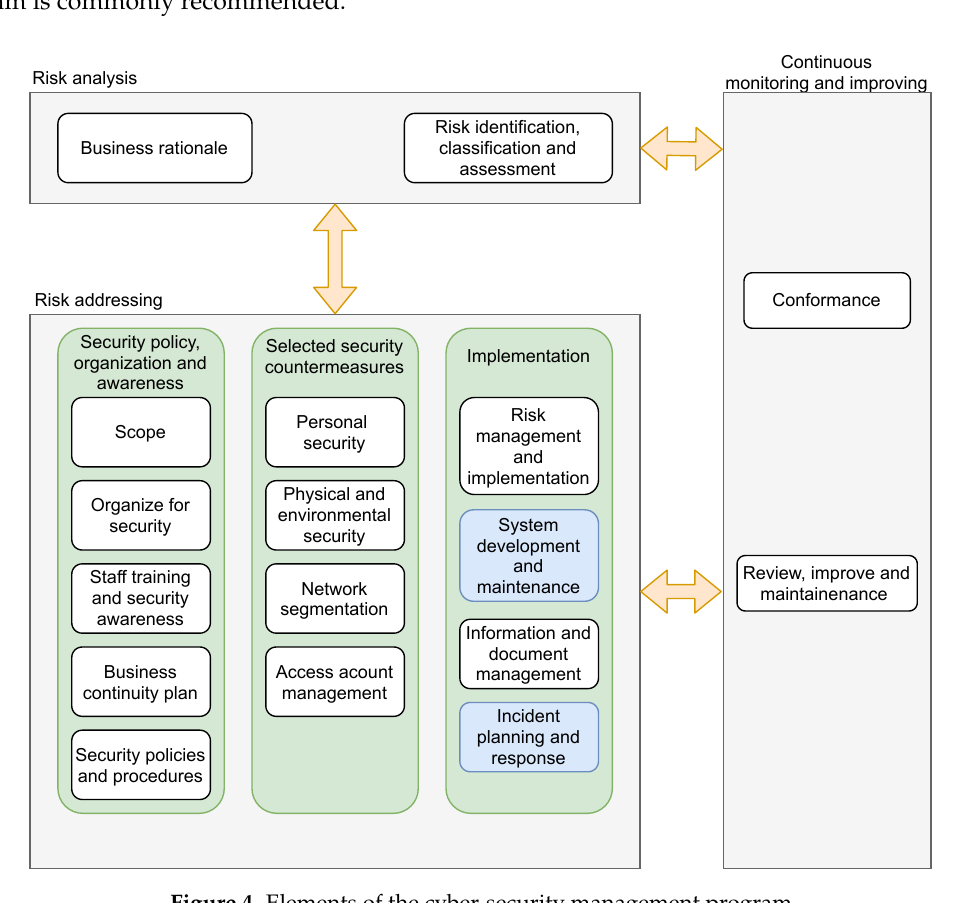
Figure 4. Elements of the cyber-security management